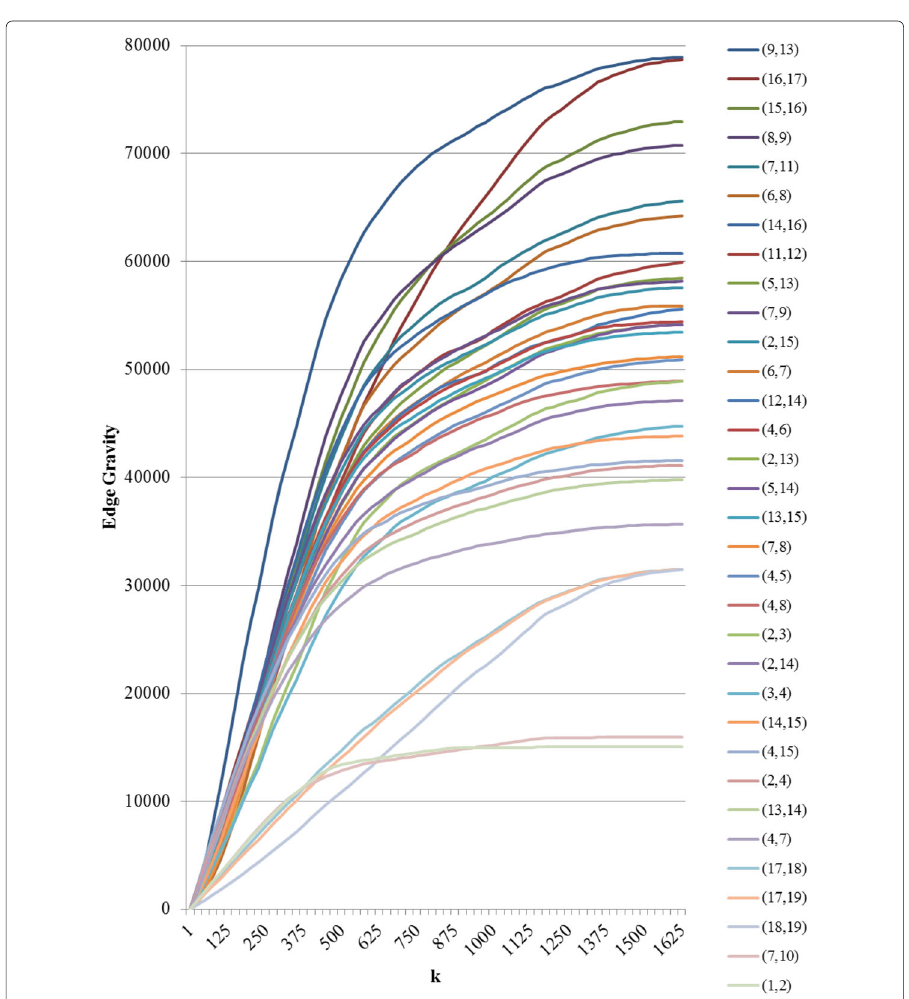
Fig. 22 Edge Gravity when solving the k-shortest path (KSP) for the augmented Krebs network, when solving for k = 1,25,50,75,100,125,150, ... ,1600,1625